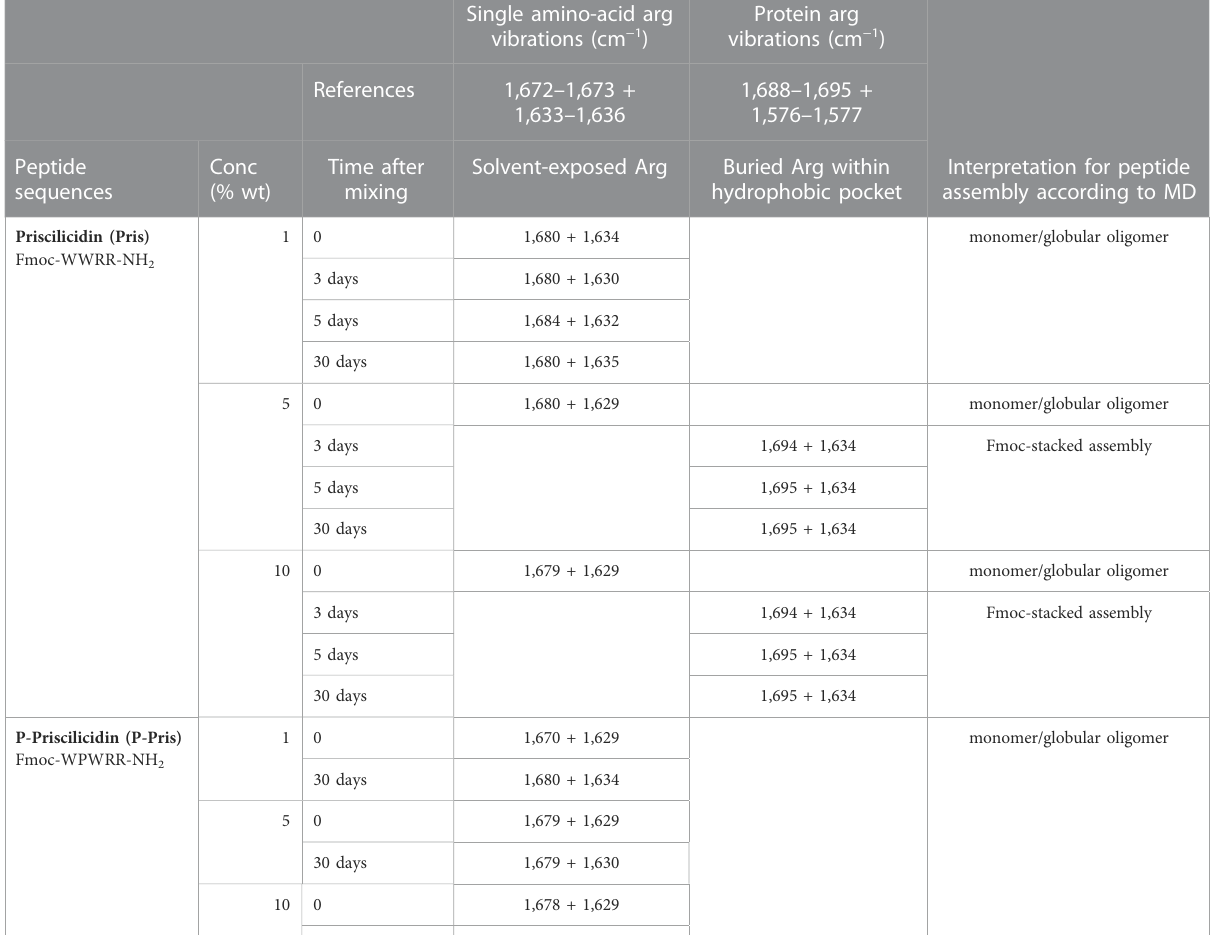
TABLE 3 ATR-FTIR shifting vibrations in the amide I region (1,700 – 1,600 cm − 1 ), assigned as solvent-exposed arginine side-chain within peptide monomer/ small oligomer (blue) or arginine side-chain buried within peptide self-assembly Fmoc-stacked core